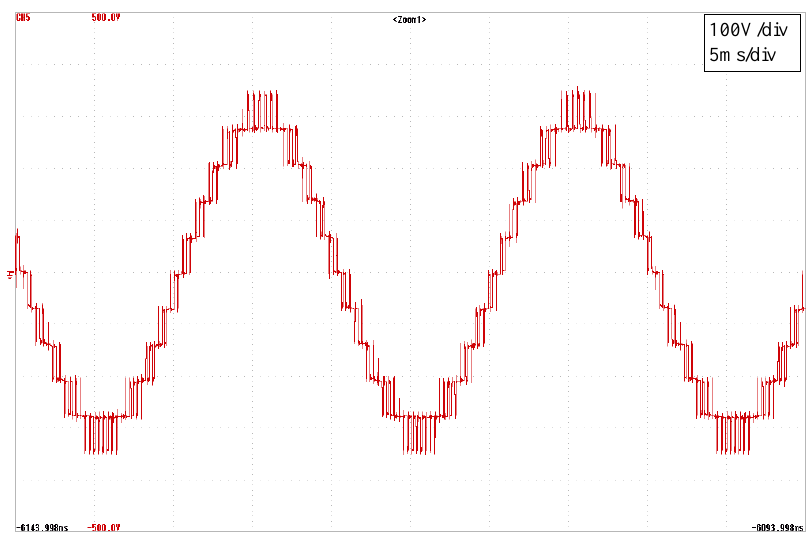
Figure 24. NLM line-to-line output waveform without load.